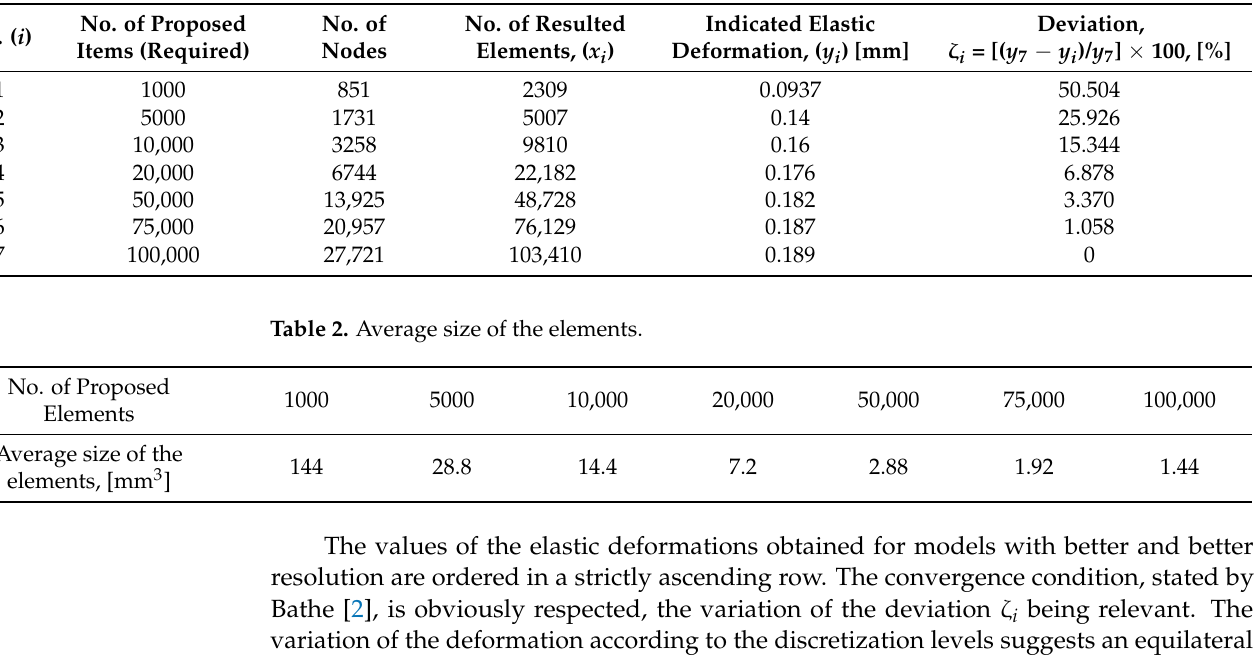
Table 1. Values obtained at the study by finite element analysis of the PAI 25 press frame.